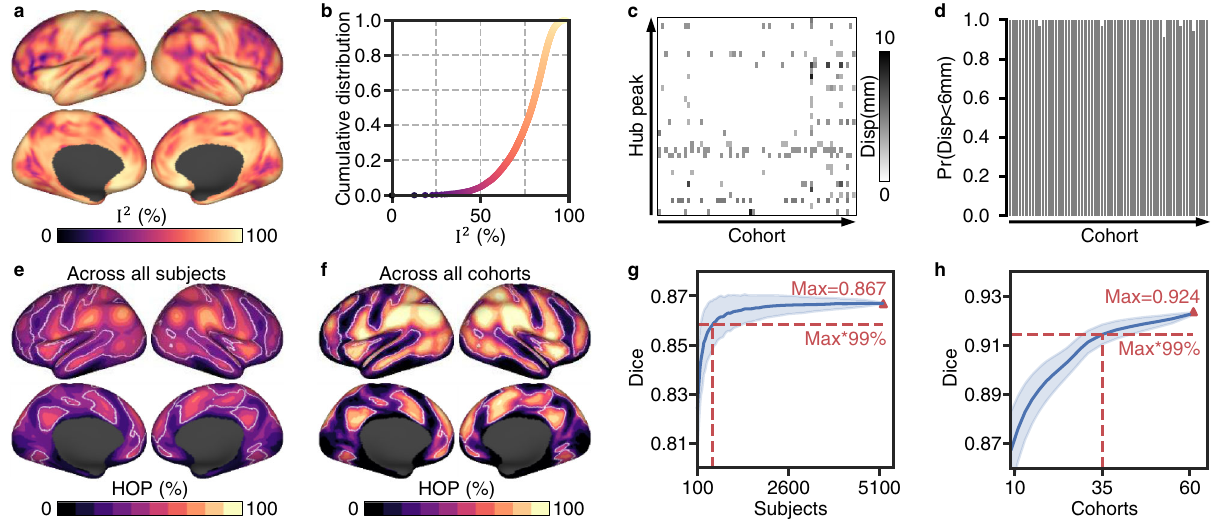
Fig. 2 The identi fi ed connectome hubs are reproducible across cohorts and individuals. a Heterogeneity measurement I 2 estimated through the random- effects meta-analysis. b Cumulative distribution function plot of I 2 . c Heatmap of displacements of the 35 hub peaks after leaving one cohort out. d Bar plot of the probability across the 35 hub peaks whose displacement was less than 6 mm after leaving one cohort out. e , f Hub occurrence probability (HOP) map across all subjects ( e ) and all cohorts ( f ). White lines delineate boundaries of the identi fi ed hubs in Fig. 1c. g , h Dice ’ s coef fi cient of the identi fi ed hubs in Fig. 1c compared with the top N (voxel number of the identi fi ed hubs in Fig. 1c) voxels with the highest hub occurrence probability values across randomly selected subjects ( g ) and randomly selected cohorts ( h ). Blue shading represents the standard deviation across 2000 random indicated that the identi fi ed connectome hubs were highly reproducible both across cohorts and across individuals.